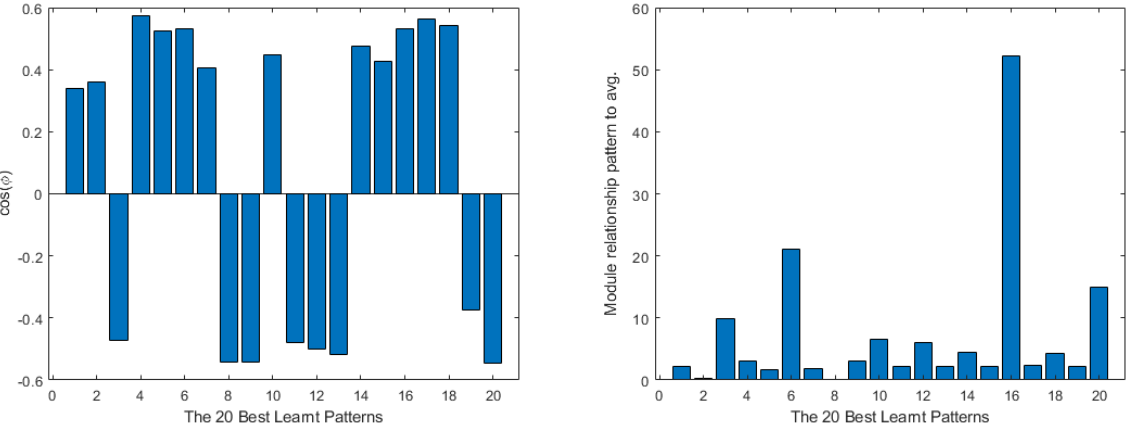
Figure 21. Unified best learned patterns cos(φ) on the ( left ) and | 𝜕𝐿𝑜𝑠𝑠 𝜕𝑊 𝑛 | on the ( right ) for the Cross-in-Tray function using the standard SGD.